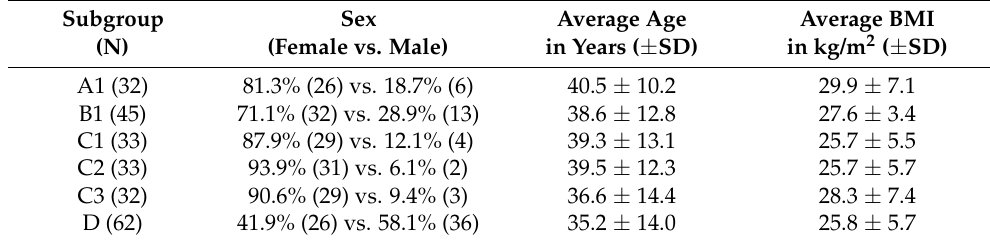
Table 1. Characteristics of the studied subgroups in terms of sex, age and BMI.